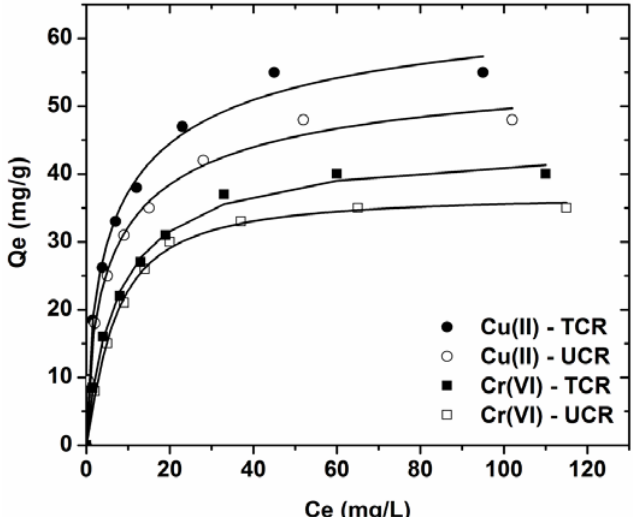
Figure 4. Effect of initial ion concentration on adsorption of Cu(II) and Cr(VI) onto treated and untreated coffee residues (pH = 5, 0–50 mg/L ion concentration, 1 g/L adsorbent, T = 25 °C, 140 rpm, 5 min–24 h